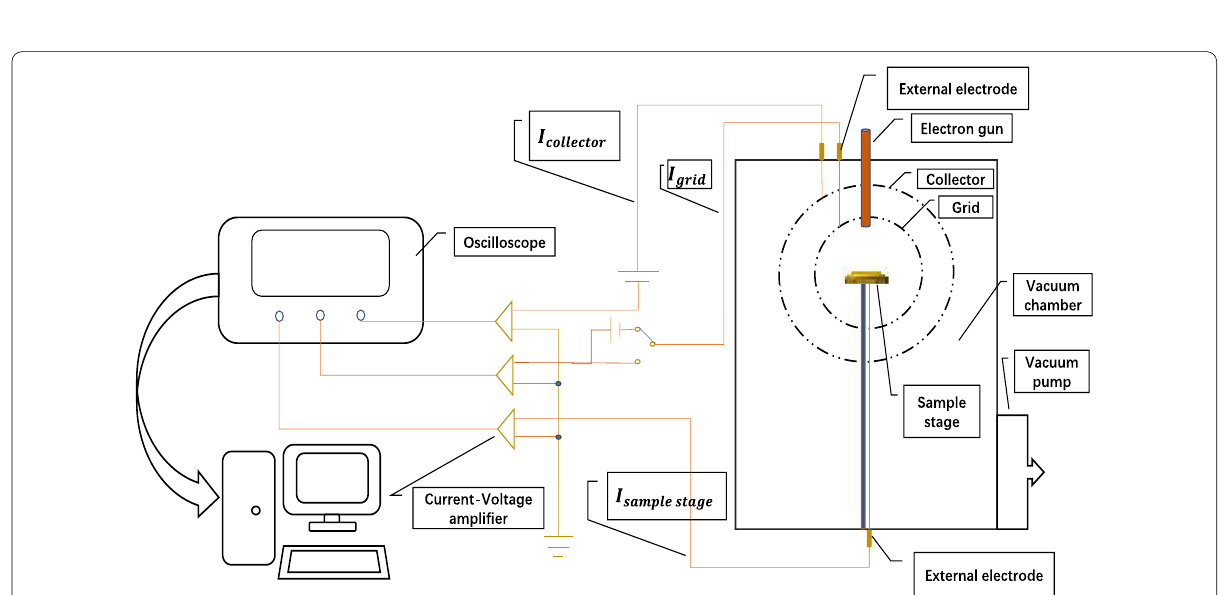
Fig.4 Schematic diagram of secondary electron emission efficiency